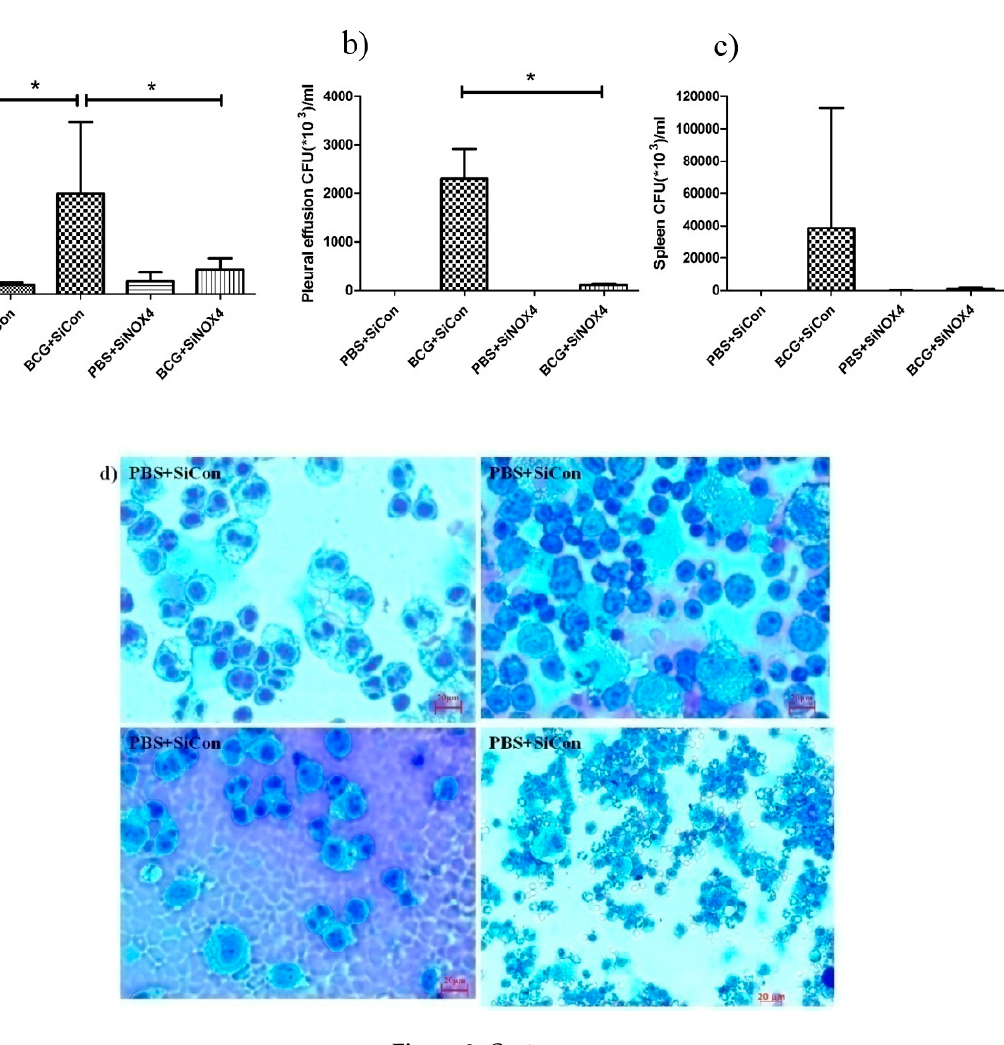
Figure 8. BCG-induced pleurisy and accumulation of cells in the pleural cavity. ( a ) Total number of cells in the pleural cavities in four groups (PBS + SiCon group, BCG + SiCon group, PBS + SiNOX4 group, and BCG + SiNOX4 group) Seven mice per group were analyzed. ( b ) Bacterial load in pleural effusion in four groups. ( c ) Bacterial load in spleen in four groups. ( d ) Photomicrographs from cytospin stained with Giemsa. ( e ) Cytokine levels (Interferon- ɤ , IL-2 TNF- α , MCP-1, and IL-6) were assessed in the pleural fluid. * p < 0.05.